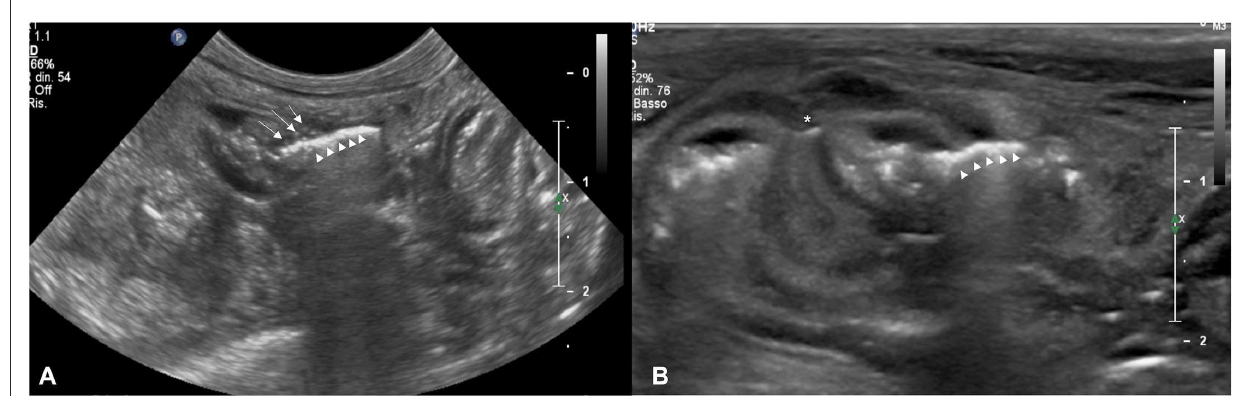
FIGURE1 (A) Transverse sonogram of an intestinal dehiscence in a dog with termino-terminalis anastomosis obtained with a microconvex probe. Note the mild wall thickening with reduced layering associated with hyperechoic foci (white arrows) coherent with suture material. Hy-perechoic linear interface (withe arrows head) associated with a dirty acoustic shadowing crossing the intestinal wall to free-float in peritoneal cavity is also evident. (B) Transverse sono-gram of an intestinal dehiscence in a dog with termino-terminalis anastomosis and serosal patching (white asterisk) obtained with a linear probe. Note the moderate wall thickening with the prominence of muscular layer. Hyperechoic linear interface (withe arrows head) associated with dirty acoustic shadowing and reverberation crossing the intestinal wall at the level of suture site is also evident. The mesentery around the dehiscence is thickened and hyperechoic.